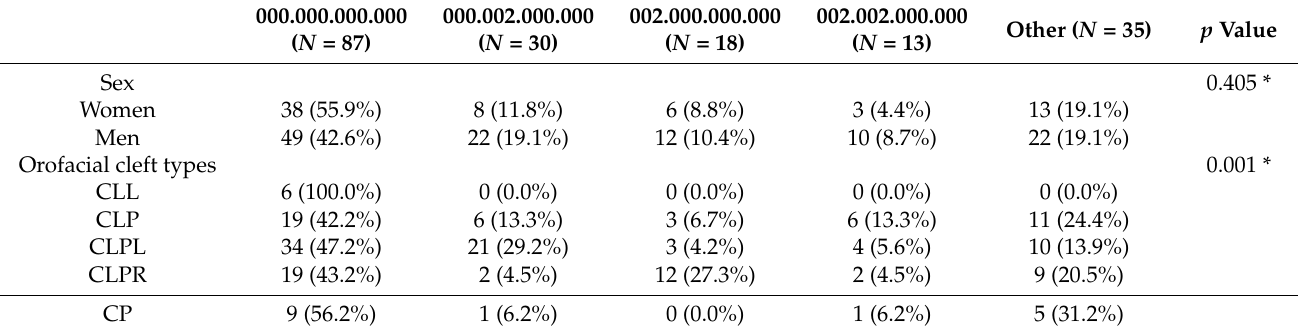
Table 3. Distribution of tooth agenesis code (TAC) by gender and cleft